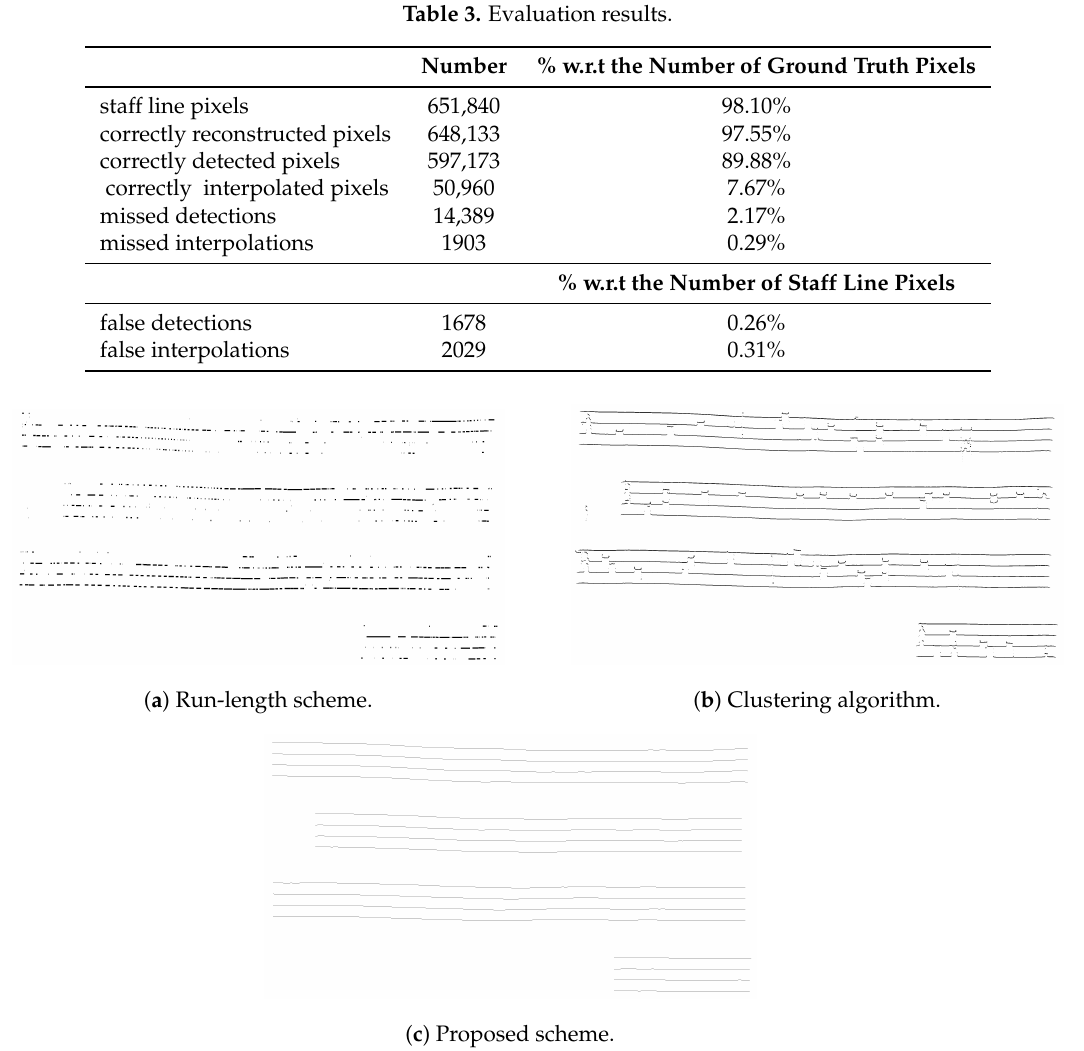
Figure 11. Illustration of the behavior of selected schemes on folio 7r of Salzinnes book; detail of the top three